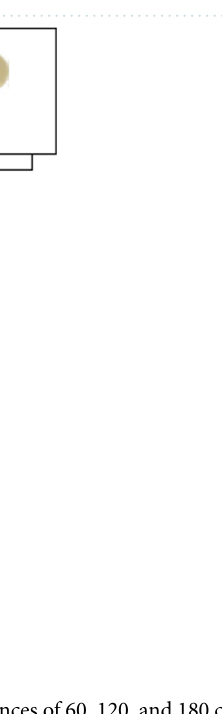
Figure 1. ( A ) The 1014 diamond bur connected to a high speed handpiece to access incisors; ( B ) a representative image of direction of access surgery performed with diamond bur; ( C ) the E6D ultrasonic insert; ( D ) a representative image of direction of access surgery performed with E6D ultrasonic insert; ( E ) the E7D ultrasonic insert; ( F ) a representative image of access cavity refining moment; ( G ) the ultrasonic insert water system arrangement; ( H ) the aspiration sucker device employed in the experiments.